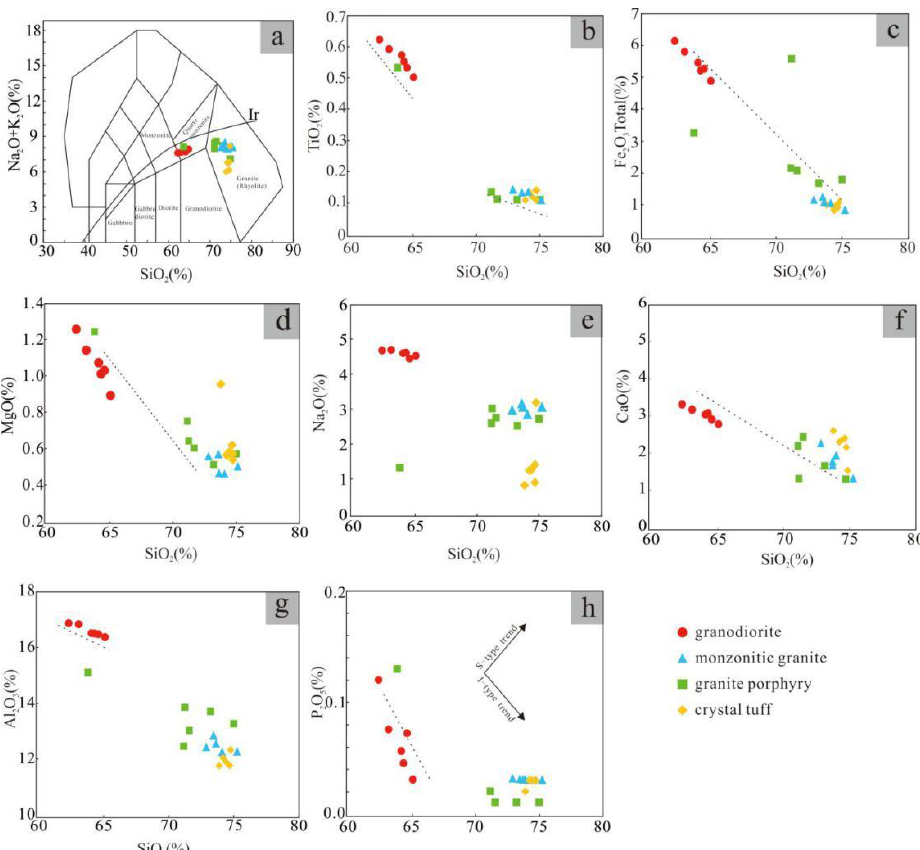
Figure 9. ( a – h ) Plots of major-element contents vs. SiO 2 content for Hutouya granitic rocks and crystal tuff.